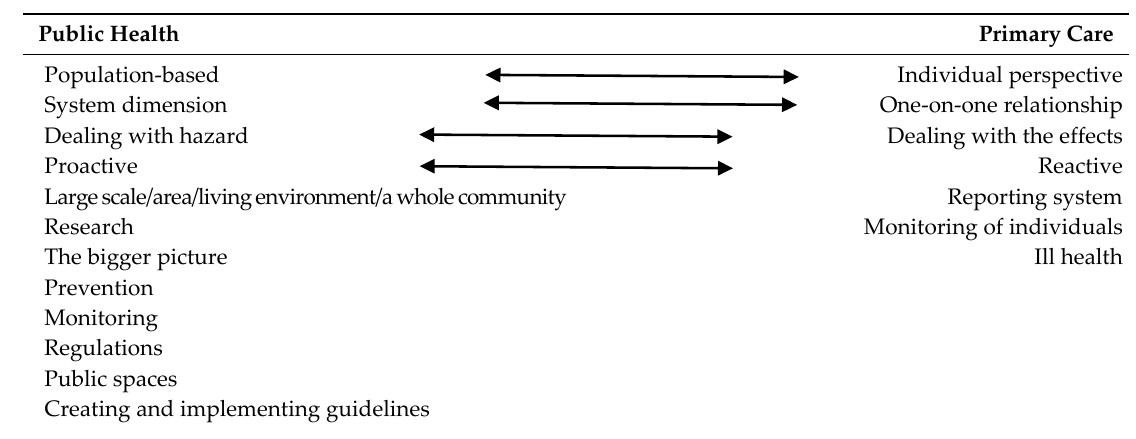
Table 5. Decision Table 5. Decision tools.